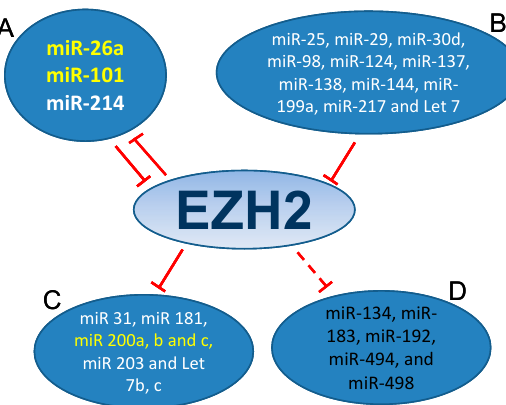
Figure 2. EZH2-miRNA network. The circles ( A , B ) show the miRNAs that regulate EZH2 by interacting with its 3 ′ UTR. Circle ( A ) includes those miRNAs that, besides regulating EZH2, are also regulated/silenced by EZH2. The circles ( C , D ) indicate those miRNAs whose expressions are suppressed by EZH2 ( C ) or whose expression are silenced by hypermethylation ( D ). In white, the miRNAs with experimental evidence of EZH2 interaction; those that are also observed in BC are denoted in yellow; and in black those miRNAs without direct evidence of expression repressed by EZH2.